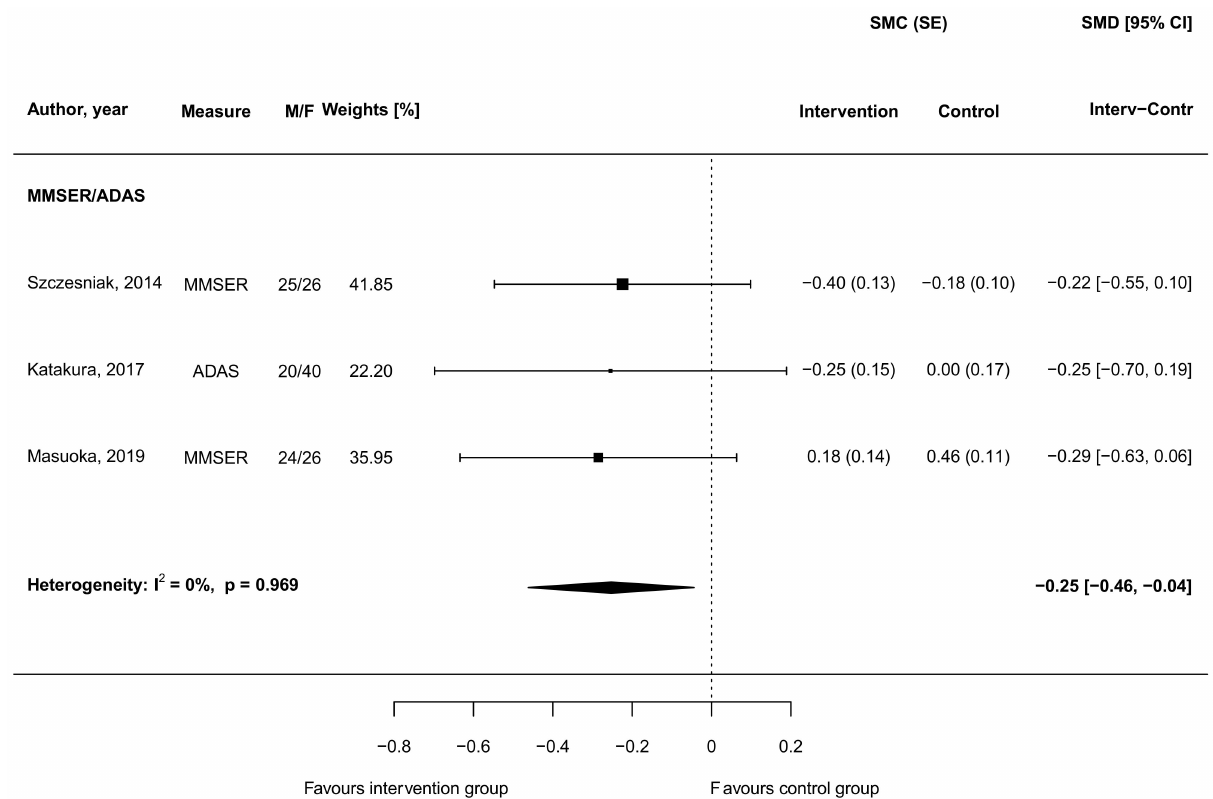
Figure 3. Standardized mean differences in cognitive outputs between intervention groups supplemented with carnosine and control groups in randomized controlled trials. Abbreviations: ADAS (Alzheimer’s Disease Assessment Scale), CI (confidence interval), F (female), M (male), MMSER (Mini Mental State Examination), SE (standard error), SMC (standardized mean change), SMD (standardized mean